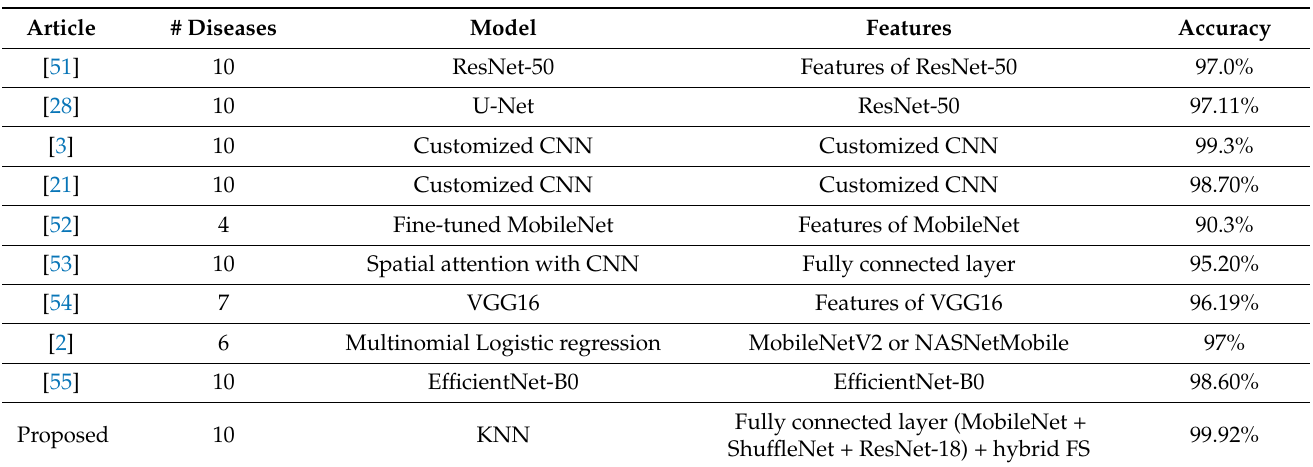
Table 5. Comparison of performance with cutting-edge models for tomato leaf disease classification based on the PlantVillage